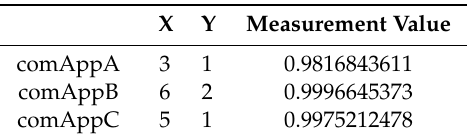
Table 5. Measurement